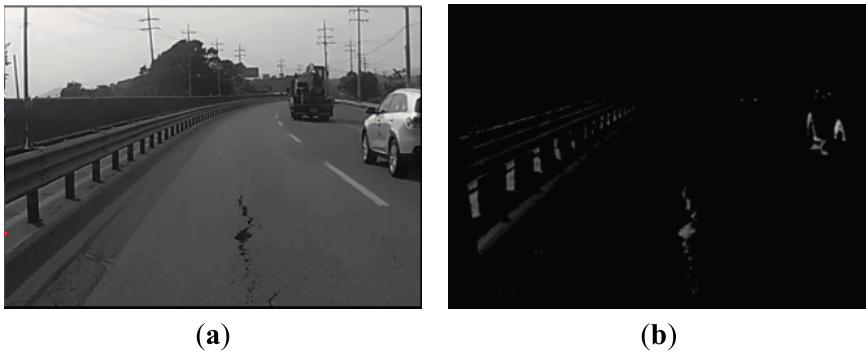
Figure 3. Pre-processing: ( a ) grayscale conversion; ( b )